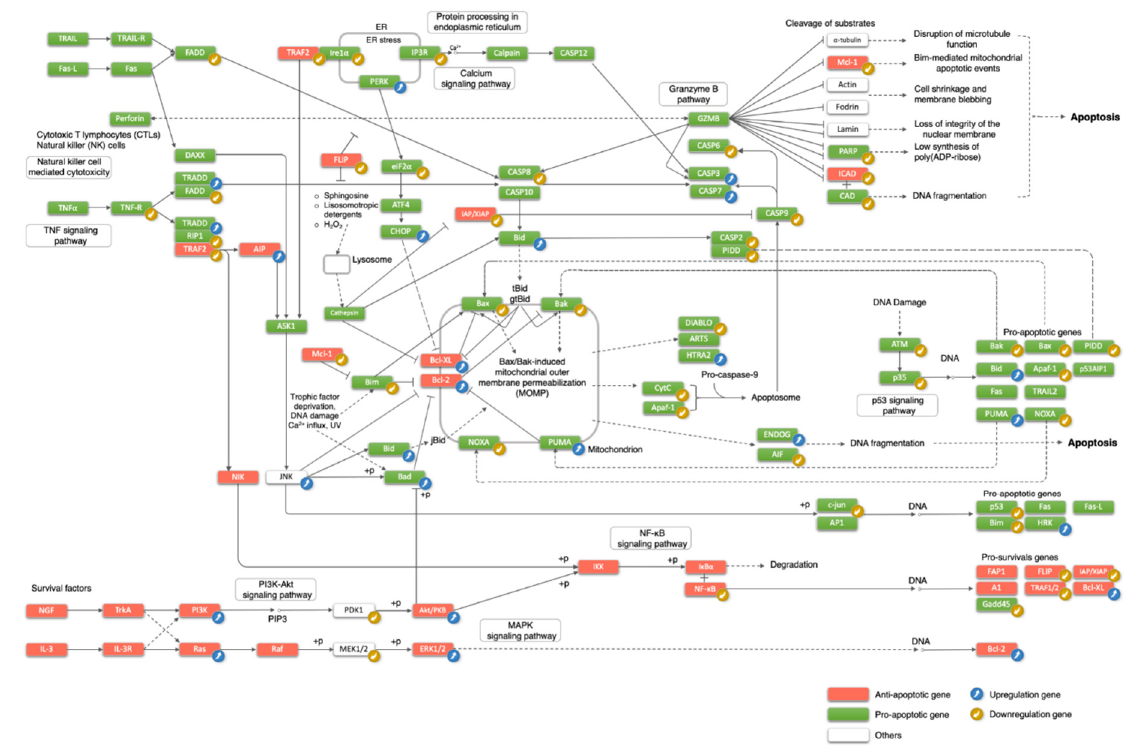
Figure 3. The classic apoptosis pathway from the KEGG database marked with regulatory directions of developmental gene expression changes and functional activity on apoptosis.